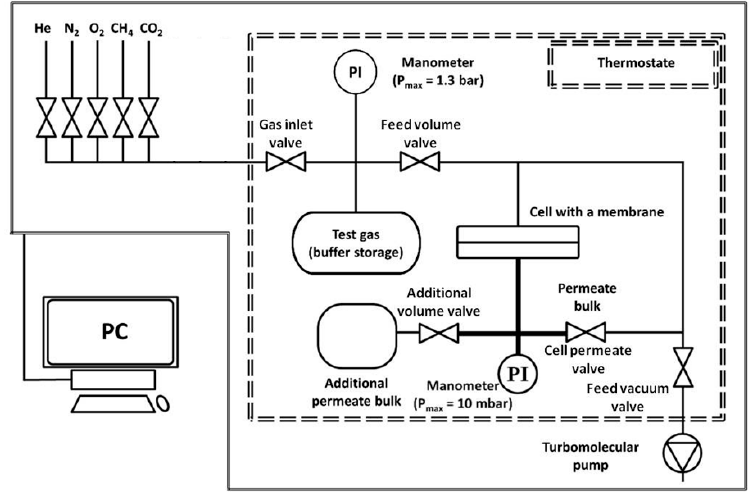
Figure 2. Schematic diagram of the “HZG G&V Permeability Test Unit” apparatus used to determine the gas transport properties of flat